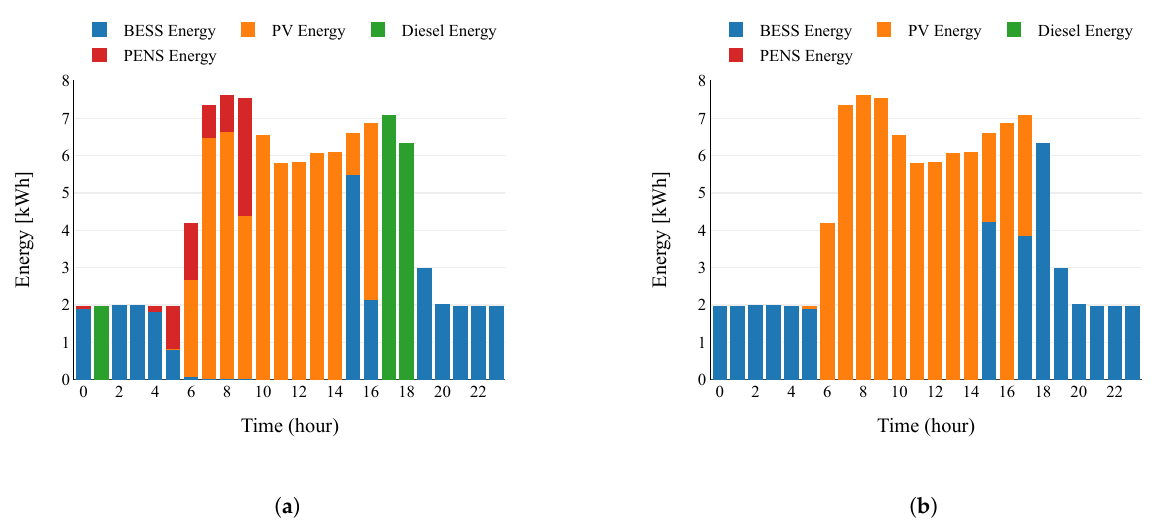
Figure 13. Energy supplied to the load in a day. ( a ) PV-BESS-DG configuration; ( b ) PV-BESS configuration.